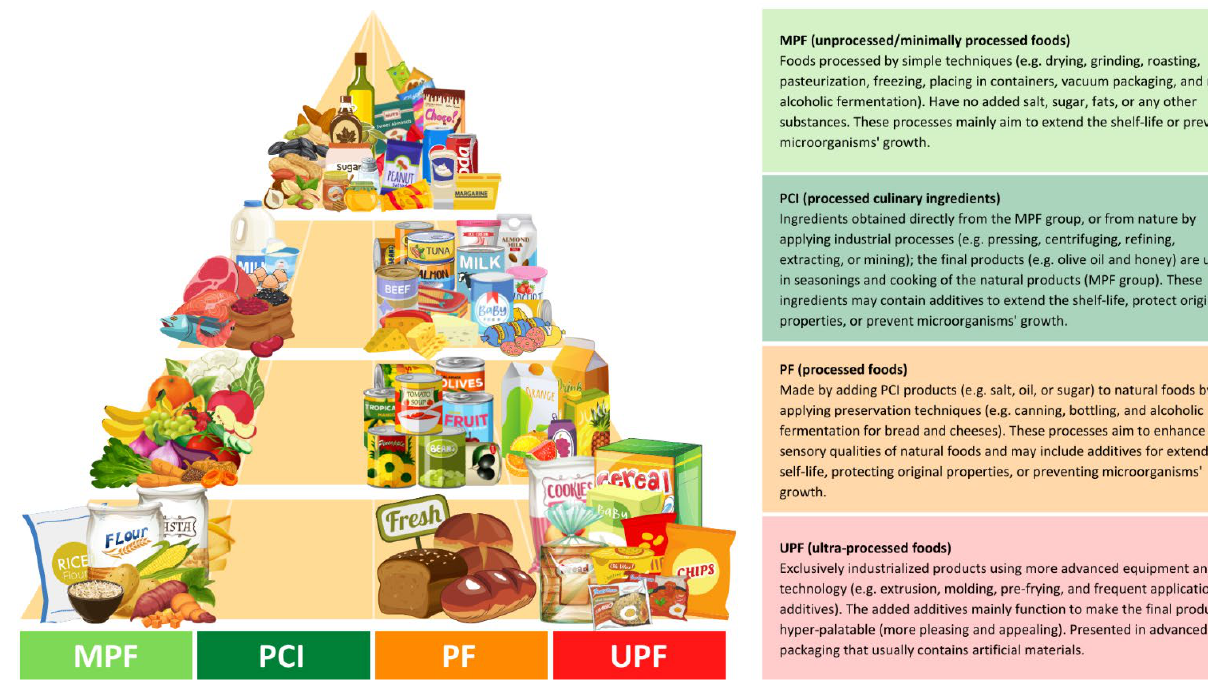
Figure 1. Distributed food examples in the food pyramid based on the NOVA classification, according to the given criteria by Monteiro et al. [13]. The different colors (light green, green, orange, and red) represent the degree of the processing; green colors (MPF and PCI) have the least level of industrial processing, orange (PF) has a modest level, and red (UPF) has the most extensive level.